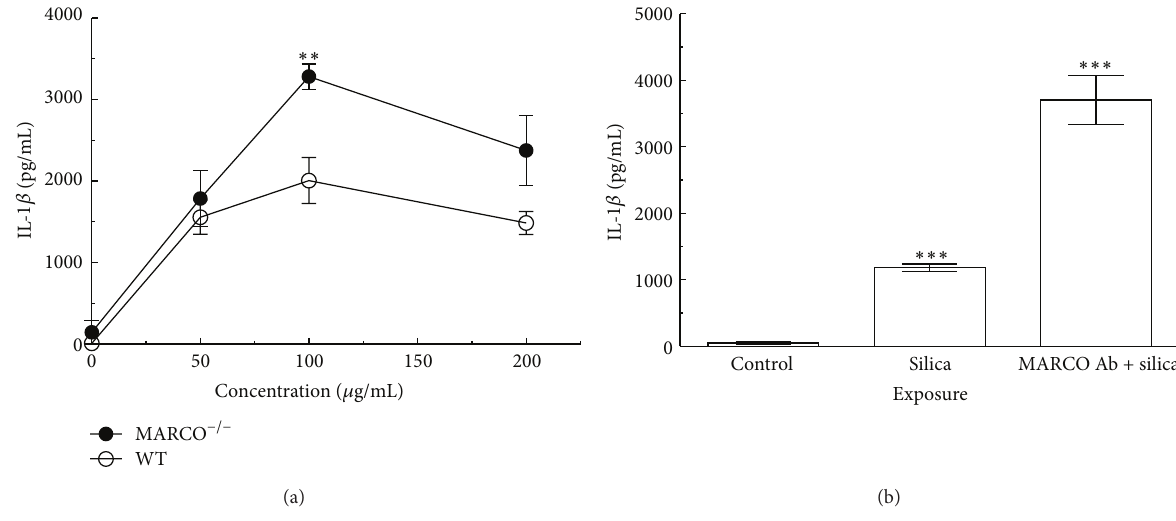
Figure 1: Evaluation of the effects of doses of silica and IL-1 𝛽 production in AM from WT and MARCO −/− mice. (a) Dose response to silica- stimulated IL-1 𝛽 release from AM cocultured with endotoxin (LPS at 20ng/mL) 24 hrs was measured by ELISA. Mean ± SEM IL-1 𝛽 from cultured macrophages where filled circle (cid:2) indicates MARCO −/− AM and open circle (cid:3) indicates C57BL/6 WT AM. Double asterisk ∗∗ indicates 𝑃 < 0.01 compared to WT control at the corresponding concentration, 𝑛 = 4 per experimental group. (b) IL-1 𝛽 release from WT AM with MARCO Ab. AM were pretreated with or without MARCO Ab (5 𝜇 g/mL) then exposed to silica (100 𝜇 g/mL) in the presence or